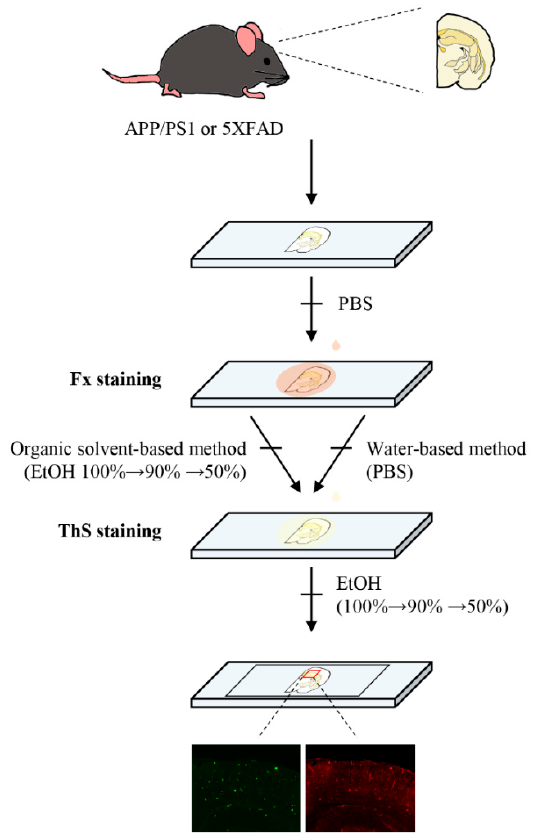
Figure 1. The histological staining process for fucoxanthin (Fx) in transgenic AD mice brain tissue. Different washing solutions, water- or organic solvent-based, were applied in the staining process.